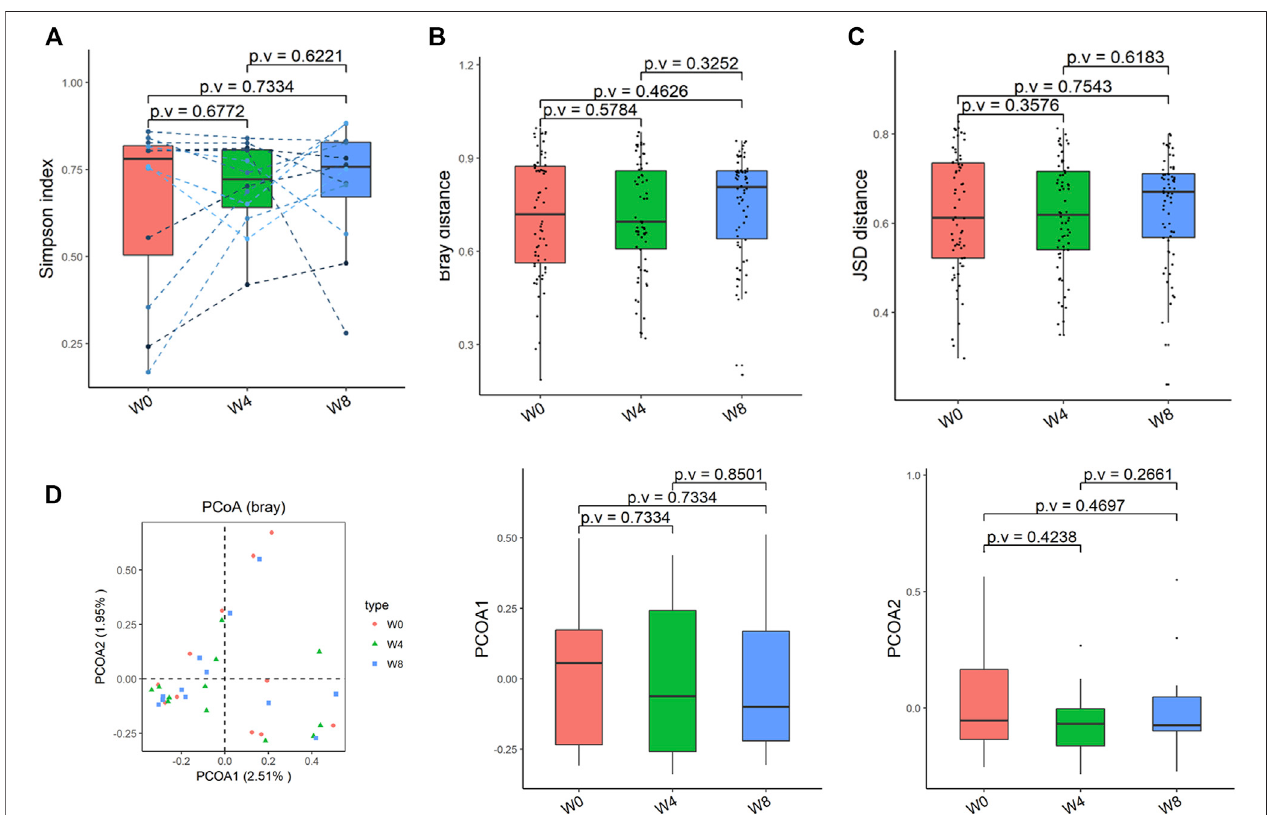
FIGURE 2 | Alpha-diversity, beta-diversity, and principal component analysis at the species level. (A) Simpson index was not signi fi cantly different in comparisons betweenW0andW4,W0andW8,andW4andW8. (B) Nosigni fi cantdifferenceinbetadiversitybasedonBray-Curtis(Bray)distanceforW0vsW4,W0vsW8,andW4 vs W8. (C) The Jensen-Shannon Divergence (JSD) distance-based beta diversity was not signi fi cantly different in W0 vs W4, W0 vs W8, and W4 vs W8. (D) PCoA analysis based on Bray distance showed that the fi rst principal component was not signi fi cantly different in W0 vs W4, W0 vs W8, and W4 vs W8, nor the second